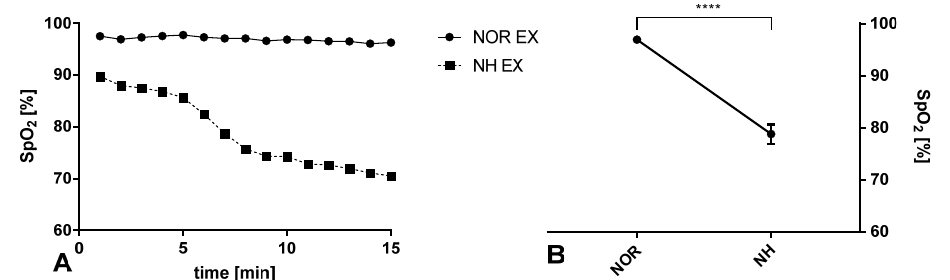
Figure 2. Effect of acute moderate exercise in normoxic and normobaric hypoxic (FIO 2 = 13%) conditions on peripheral blood saturation. NOR EX—exercise in normoxia; NH EX—exercise in normobaric hypoxia. ( A ) Data expressed as mean of the entire group at particular time points; ( B ) data show differences in means between groups. Error bars indicate ± SEM (standard error of mean). **** p < 0.0001.